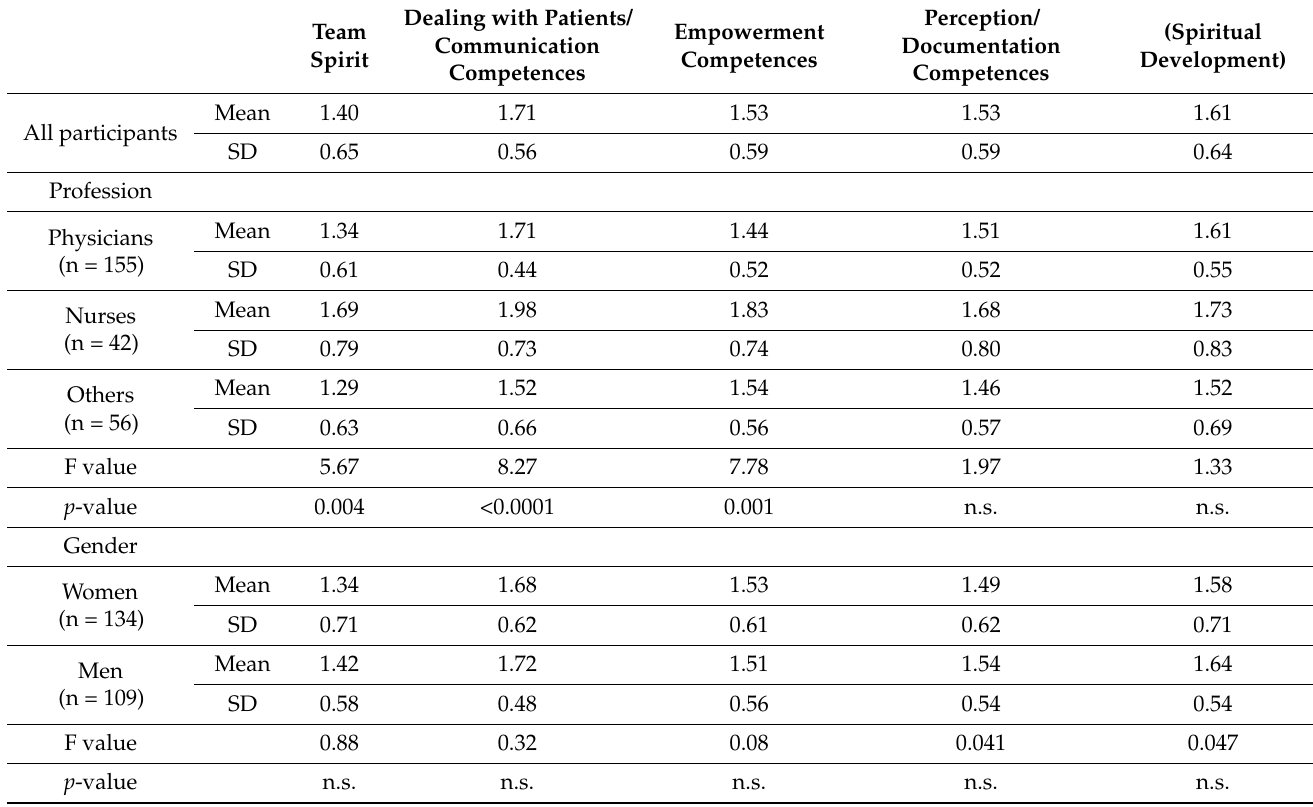
Table 3. Spiritual care competences within the